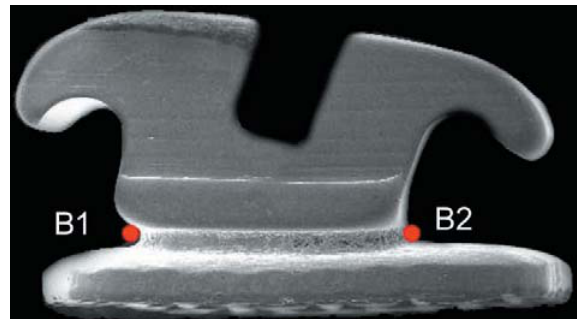
Figure 2- Points B1 and B2